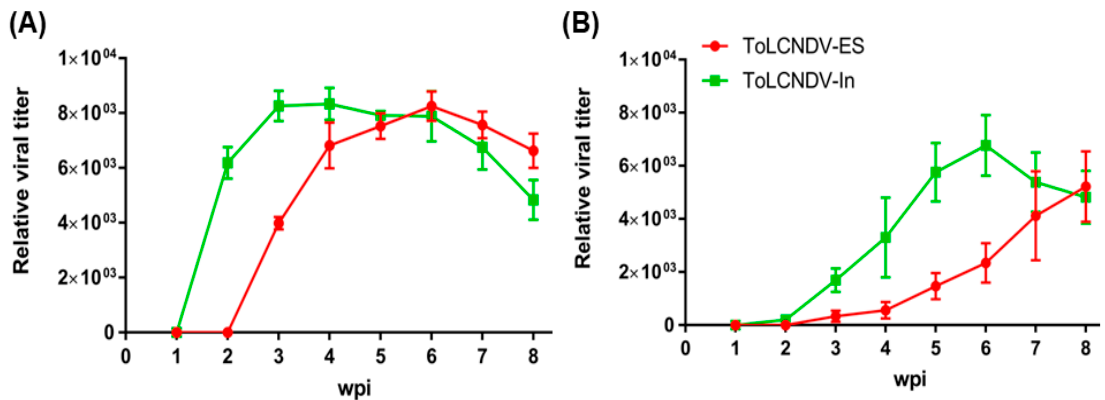
Figure 2. Relative ToLCNDV titer following the inoculated time in cucumber. Leaf samples were collected after 1–8 wpi, and relative amounts were measured by qPCR for the ( A ) DNA A and ( B ) DNA B components.